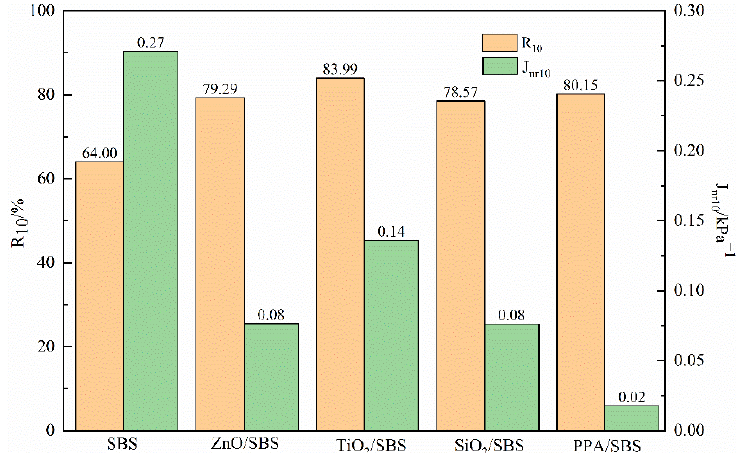
Figure 3. R 10 and J nr10 of asphalt at 10 KPa and 70 °C after RTFO aging.